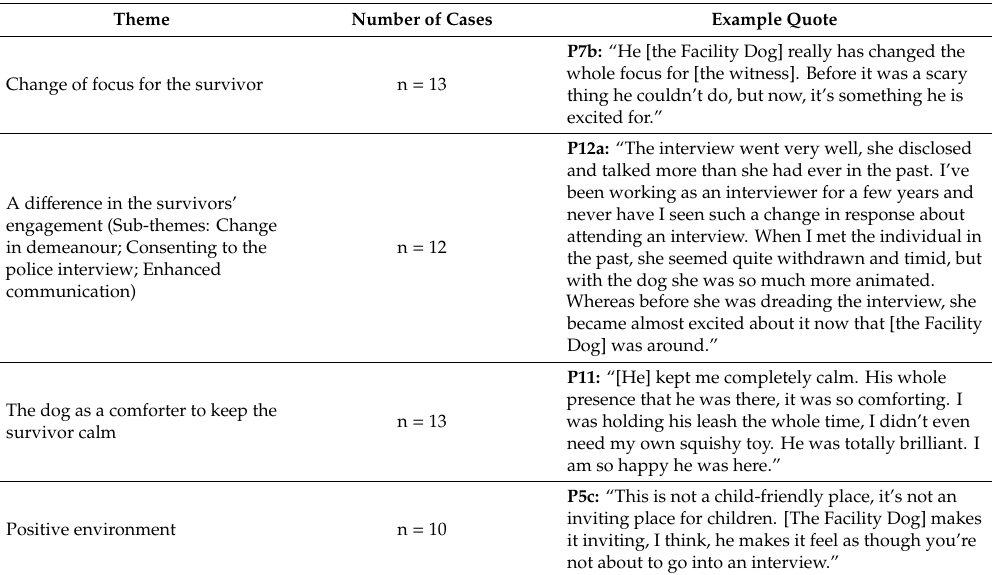
Table 2. Overview of the themes, the number of cases where the themes appeared, and example interview quotes illustrating the